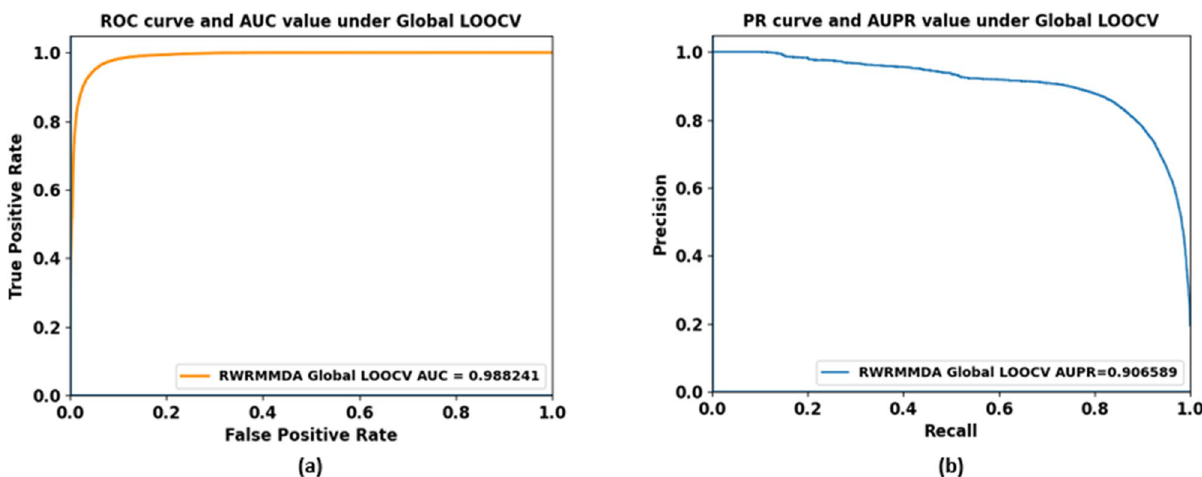
Figure 6. ROC curve and AUC value ( a ) and PR curve and AUPR value ( b ) under global LOOCV